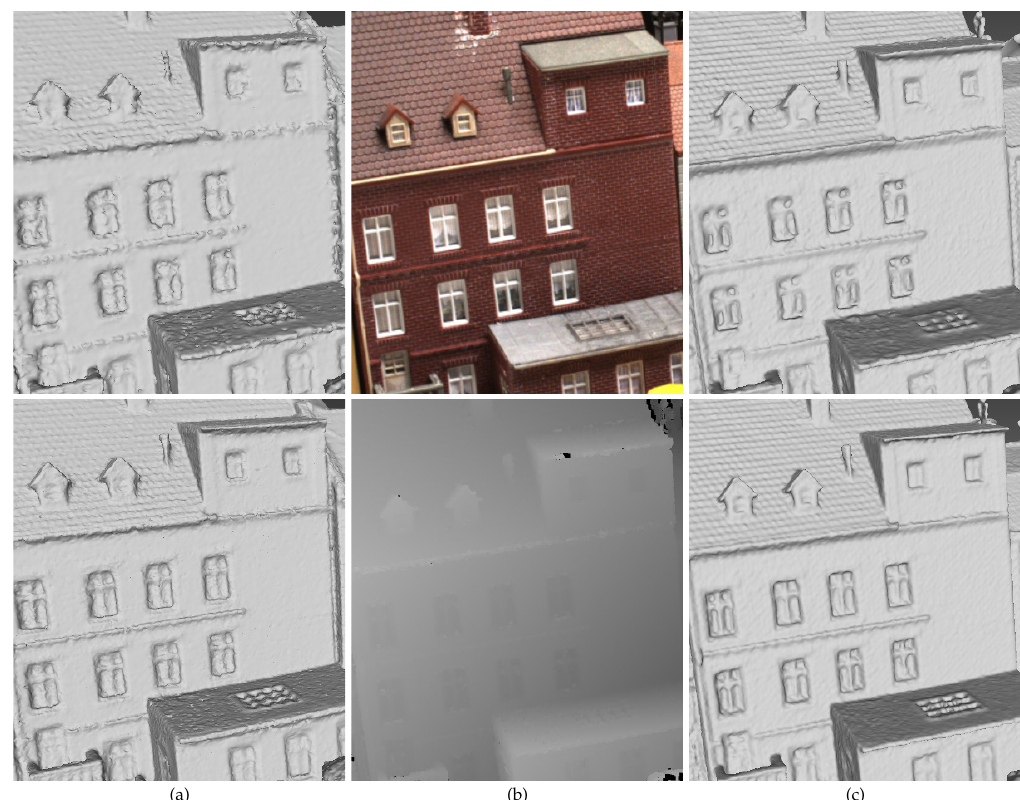
Figure 8. Object edges in the reconstructed meshes, the original image and the depth map. From left to right: ( a ) the object edges in surface meshes reconstructed by the method in [5] (top) and our method (bottom) without the dense visibility technique; ( b ) the original image and the corresponding depth map with a similar view point; and ( c ) the object edges in surface meshes reconstructed by the method in [5] (top) and our method (bottom) with the dense visibility technique.